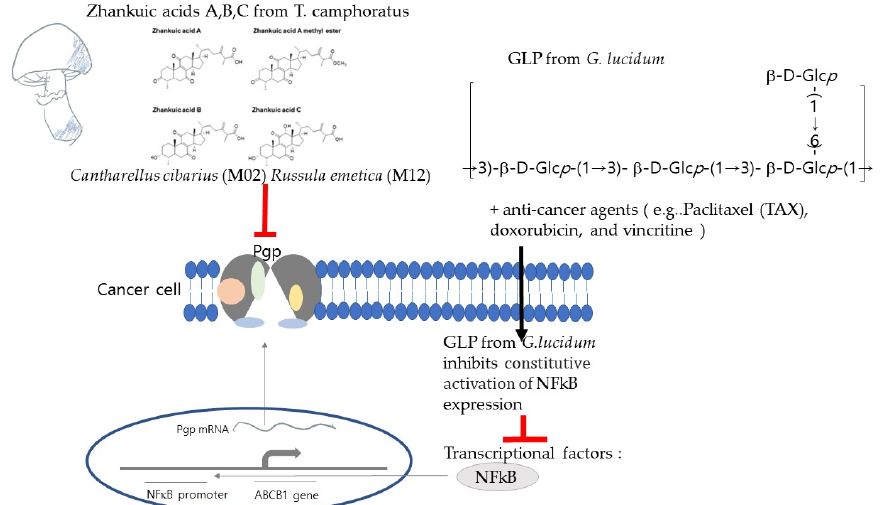
Figure 1. An illustration of the anticancer mechanisms of mushrooms by overcoming Pgp-mediated MDR. Structure of zhankuic acids A, B, and C from T. camphoratus adapted from Zhankuic Acids A, B and C from Taiwanofungus Camphoratus Act as Cytotoxicity Enhancers by Regulating P- Glycoprotein in Multi-Drug Resistant Cancer Cells. Biomolecules, 2019. 9 (12).